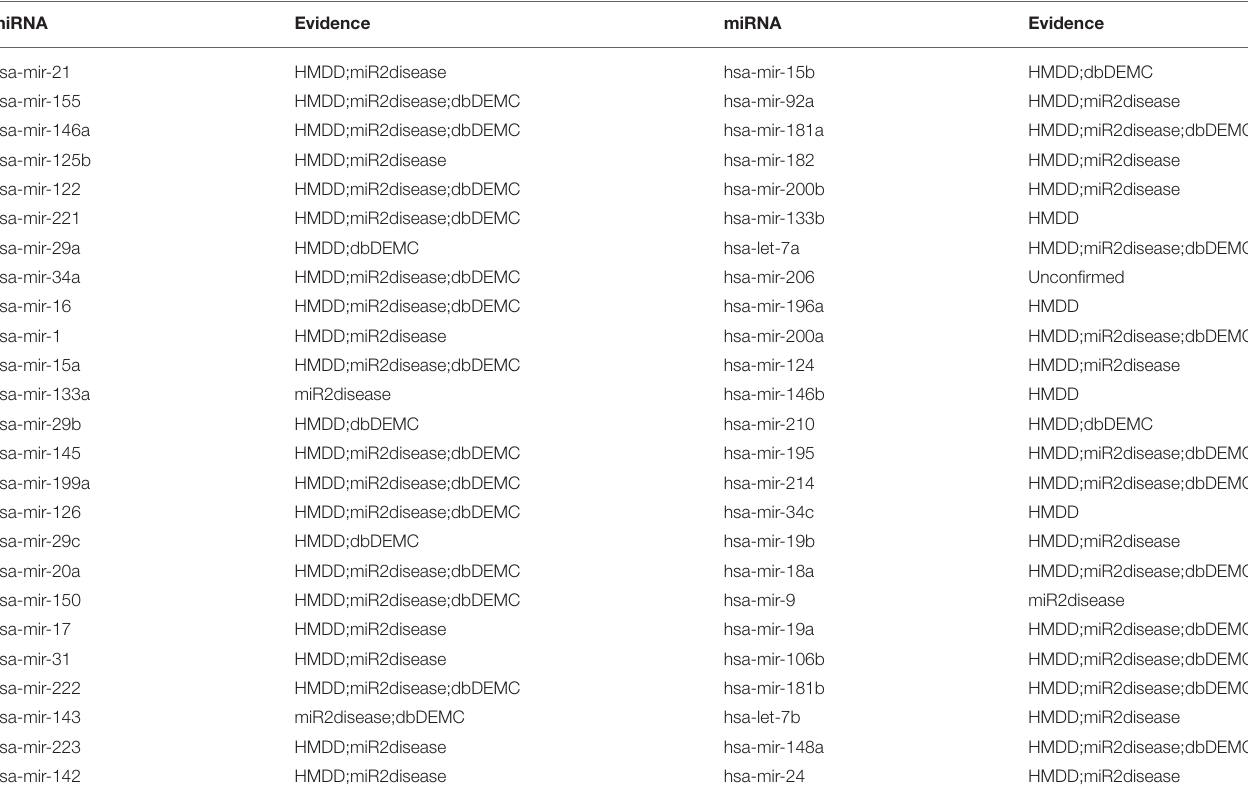
TABLE 2 | The top 50 predicted miRNAs associated with Hepatocellular Carcinoma. miRNA Evidence miRNA